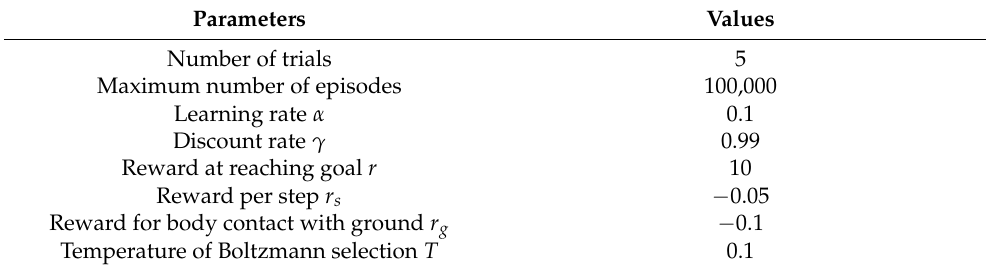
Table 1. Reinforcement learning parameters in simulation. These parameters are used for learning simulation in Webots. Parameters Values Number of trials 5 Maximum number of